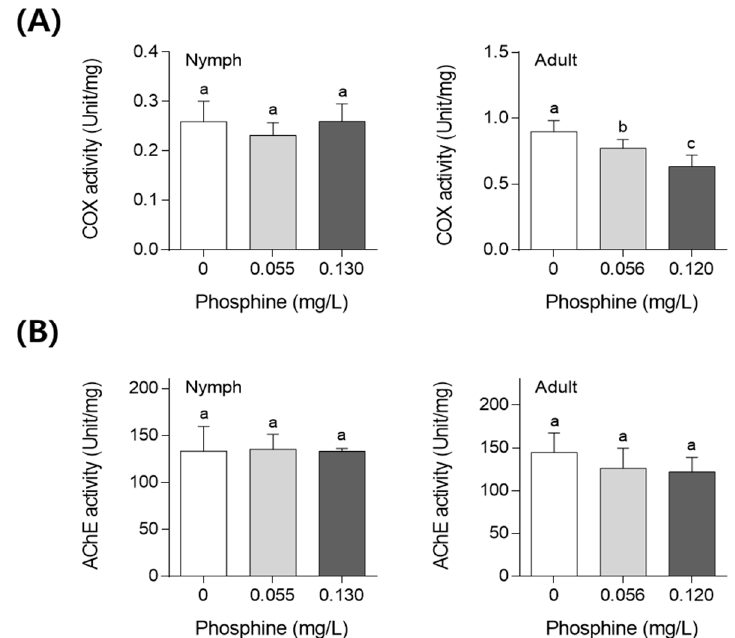
Figure 2. Enzyme assays in the two different developmental stages of Myzus persicae (nymphs and adults) after the phosphine treatment. ( A ) Cytochrome c oxidase (COX); ( B ) Acetylcholinesterase (AChE). The enzyme activities were expressed as unit/mg of the insect. Different letters on the bars indicate statistical differences between phosphine-treated samples and the control ( p < 0.05). Treated concentrations were equivalent to LC 10 (0.055 mg/L for nymphs or 0.056 mg/L for adults) and LC 50 (0.130 mg/L for nymphs or 0.120 mg/L for adults) values.